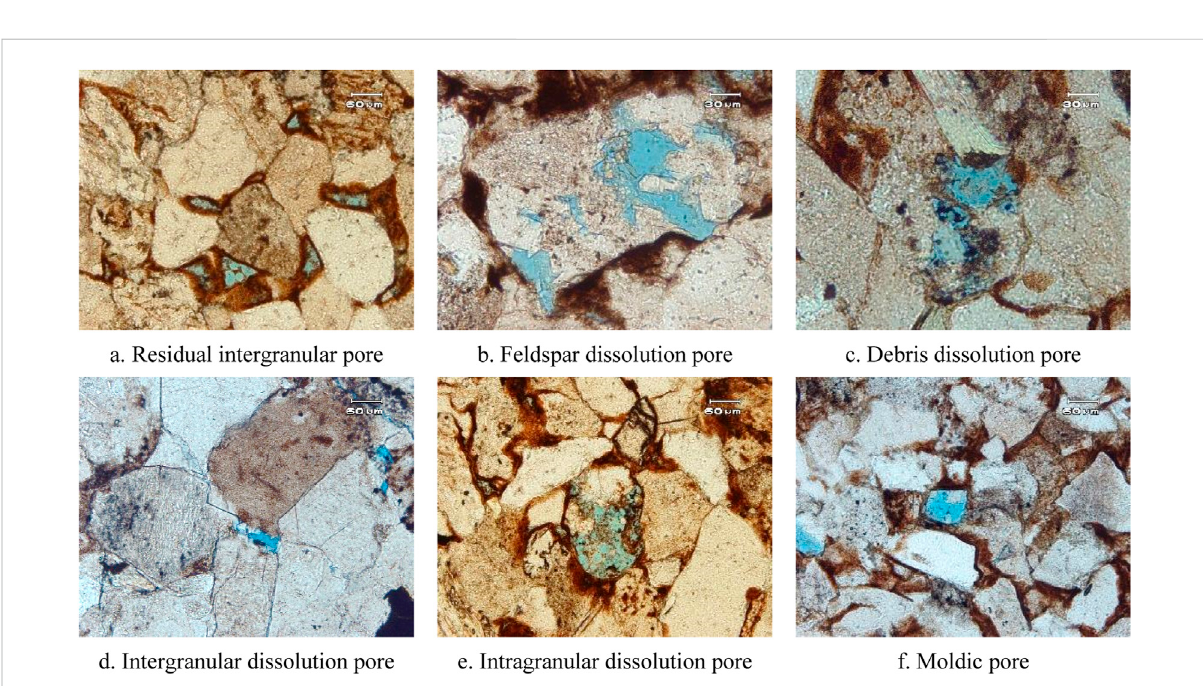
FIGURE 4 Pore types of reservoir. (A) Residual intergranular pore. (B) Feldspar dissolution pore. (C) Debris dissolution pore. (D) Intergranular dissolution pore. (E) Intragranular dissolution pore. (F) Moldic